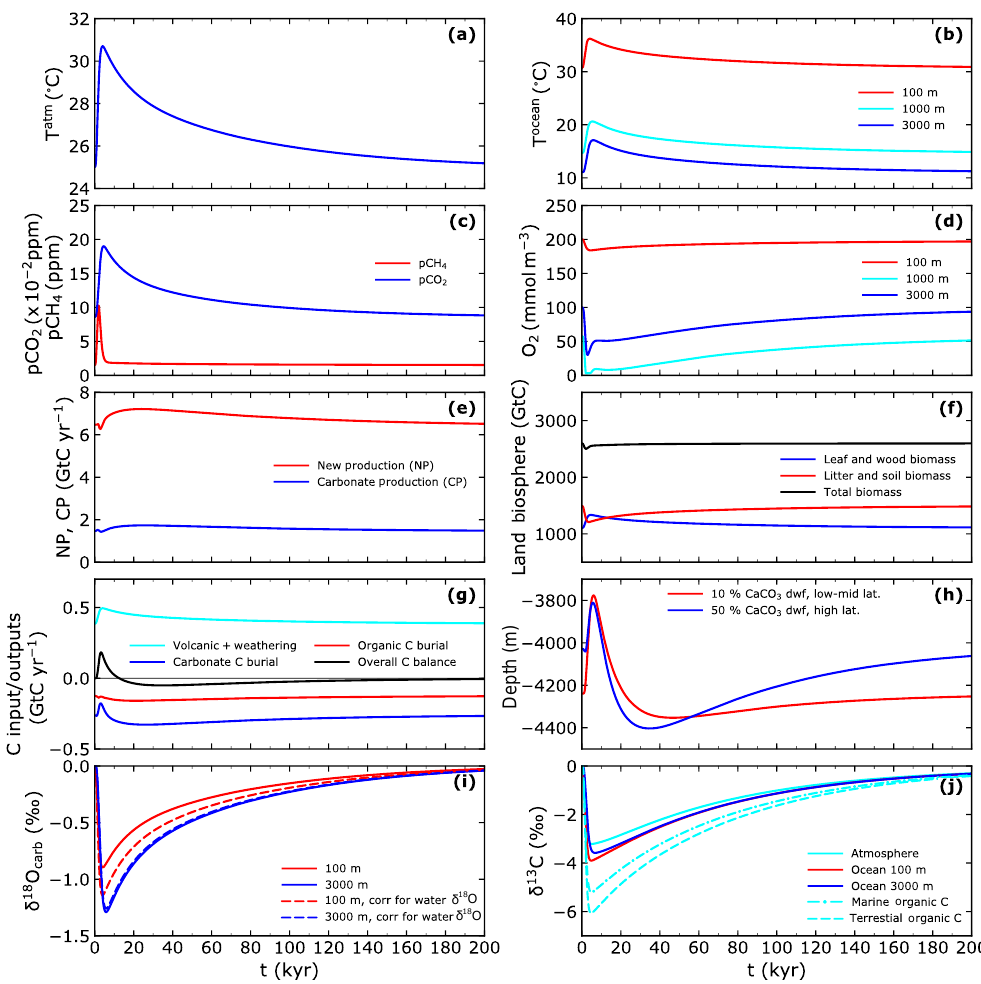
Figure 6. Results from a 200000-year simulation with a methane input of 4000GtC over a timescale of 3000 years and with half the input dissolved in the ocean and half escaping as gas to the atmosphere. (a) Global mean atmospheric temperature, (b) LL ocean tempera- ture, (c) atmospheric p CO 2 and p CH 4 , (d) LL ocean-dissolved O 2 concentration, (e) ocean new and biogenic CaCO 3 production, (f) land biosphere carbon inventories for leaves + wood, litter + soil and their total, and (g) external input/outputs of carbon. The black line is vol- canic/weathering inputs minus burial outputs. (h) Depths to the LL 10% (LL CCD) and HL 50% CaCO 3 wt%, (i) LL excursions of δ 18 O in biogenic CaCO 3 formed and those excursions corrected for excursions in ambient δ 18 O w . (j) Carbon isotope excursions for the atmosphere, the LL ocean, LL marine organic carbon and terrestrial organic carbon (see text; the methane input has δ 13 C = −